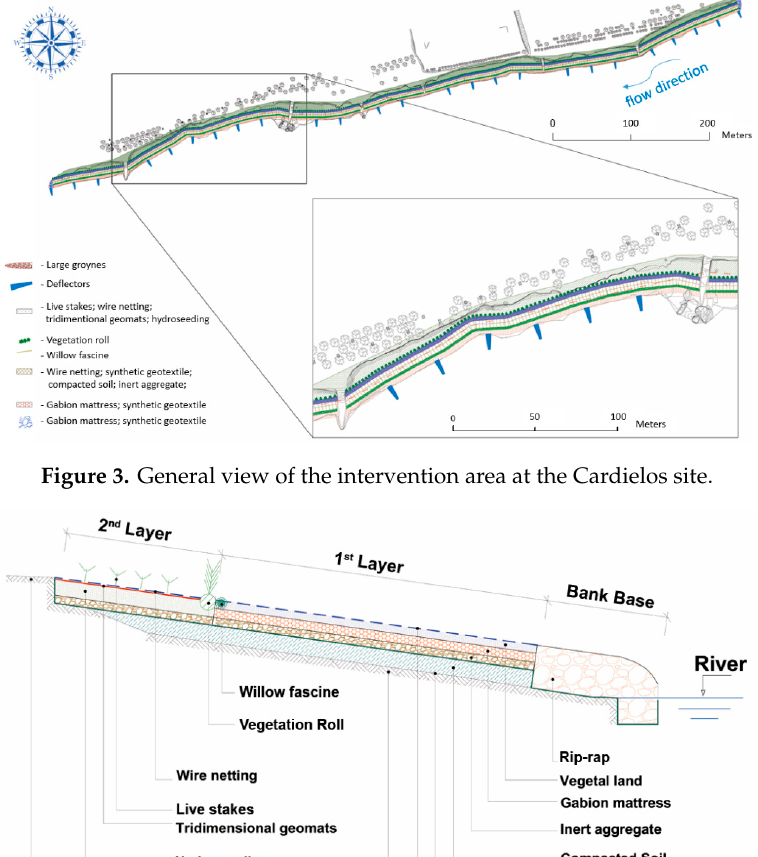
Figure 3. General view of the intervention area at the Cardielos site.